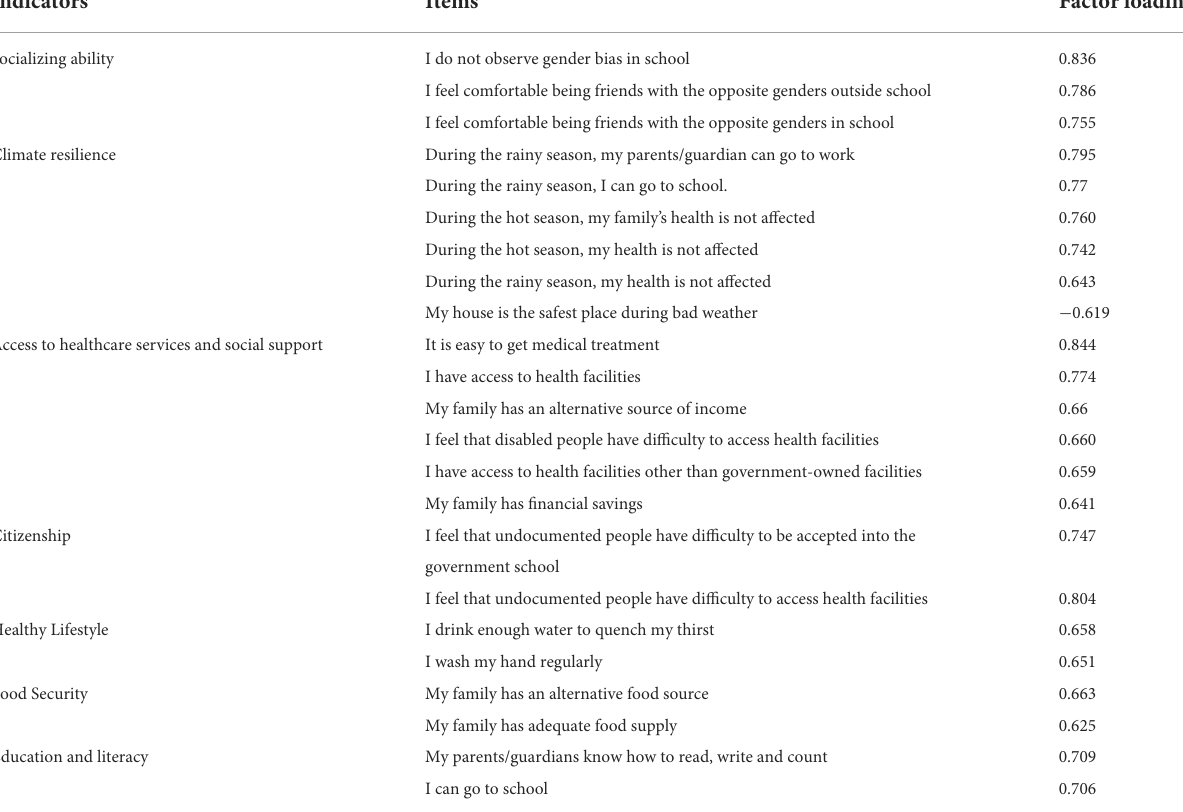
TABLE 6 Indicators and items with respective factor loadings for Pulau Gaya,